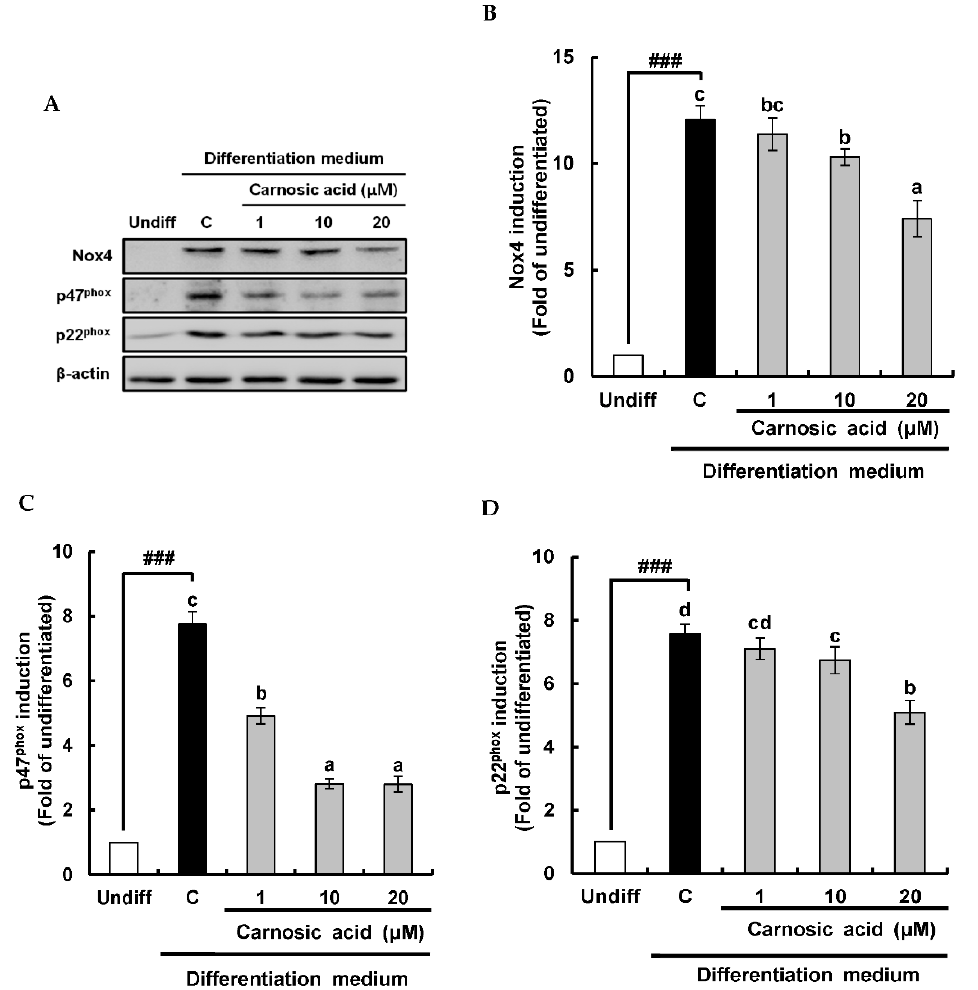
Figure 2. Inhibitory effect of carnosic acid on the translation of Nox4 enzyme components in MDI- induced differentiation of 3T3-L1 pre-adipocytes to adipocytes for two days. ( A ) Translation of Nox4, p47 phox , and p22 phox as determined by Western blotting analysis after differentiation for two days. ( B ) Graphic representation of densitometric analysis of Nox4 blot. ( C ) Graphic representation of densitometric analysis of p47 phox blot. ( D ) Graphic representation of densitometric analysis of p22 phox blot. Data are presented as averages of three independent experiments performed in triplicates and expressed as percentages of the value of control (means ± standard error mean, n = 3). ### : p < 0.001 vs. Undiff. Different corresponding letters indicate significant differences at p < 0.05 using Duncan’s test. (Undiff: undifferentiated, which was not treated with the MDI hormone mixture; C: control, which was treated with the MDI hormone